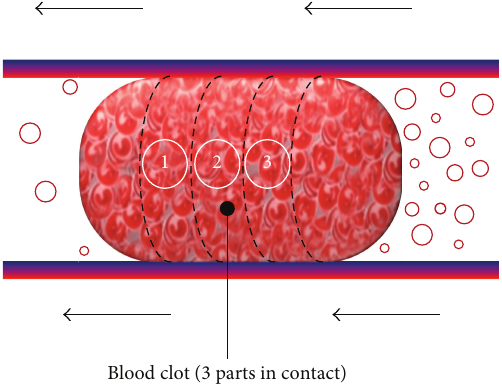
Figure 9: Blood clot 3 parts